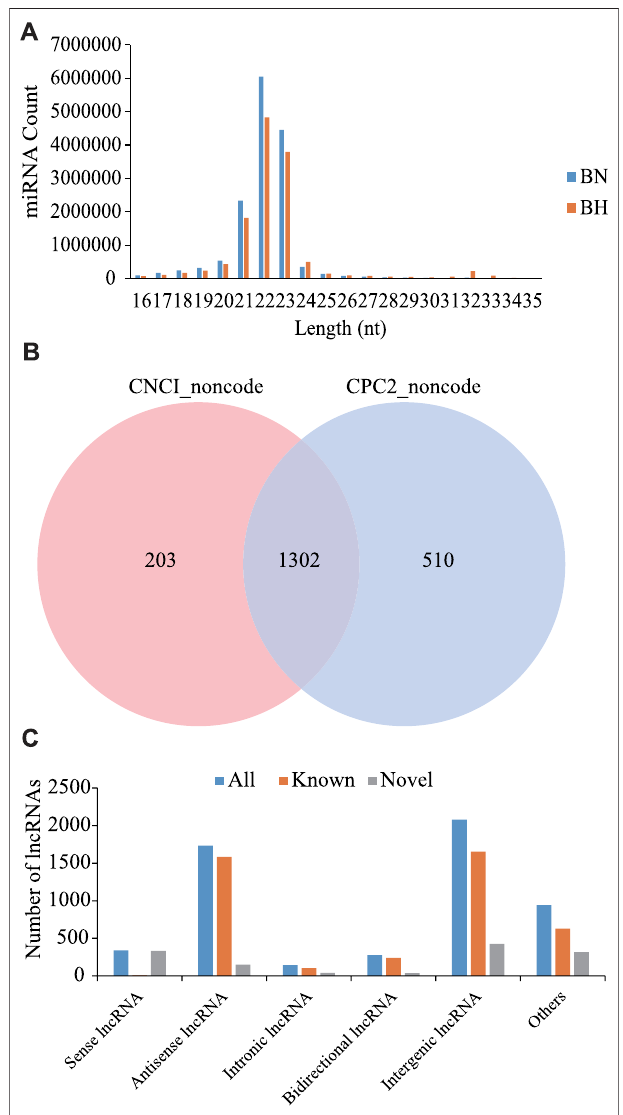
FIGURE1| Signatures ofmiRNA and lncRNA sequencingdata. (A) Size distribution of sRNAs from BN and BH libraries. (B) Venn diagrams of novel lncRNApredictionresultsbasedonCNCIandCPC2software. (C) Distribution of lncRNA types.